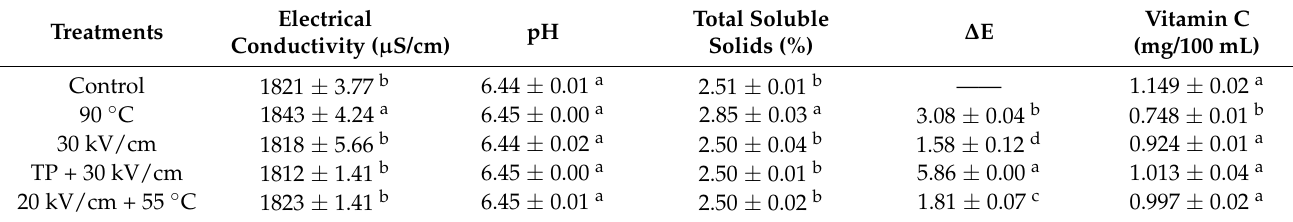
Table 1. Physicochemical changes of cantaloupe juice after PEF